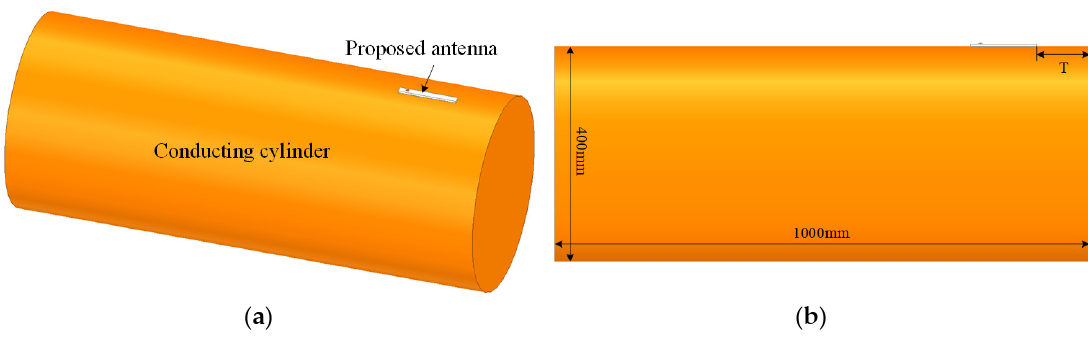
Figure 13. Configuration of the proposed antenna mounted on the surface of a conducting cylinder: ( a ) trimetric view; ( b ) side view.